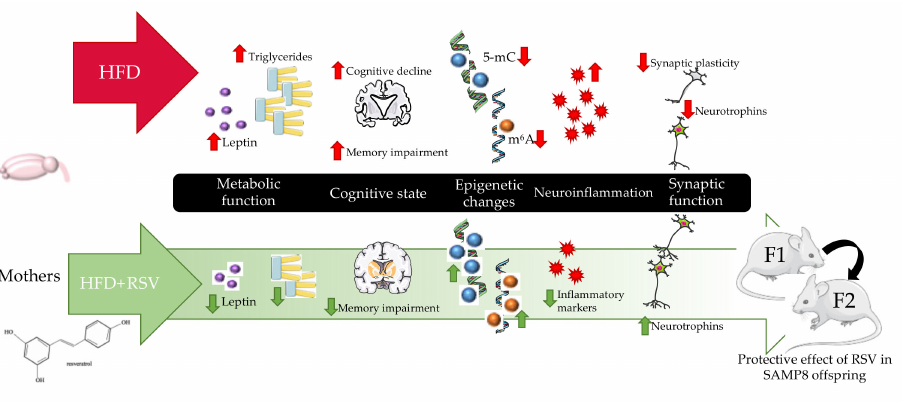
Figure 6. Schematic representation of the neuroprotective effects observed of maternal RSV intake under HFD across generations in